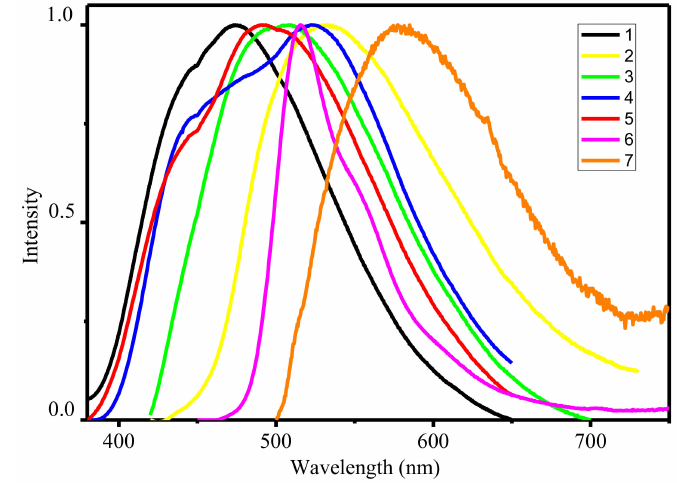
Figure 3. Normalized emission spectra of zinc complexes in solid state.